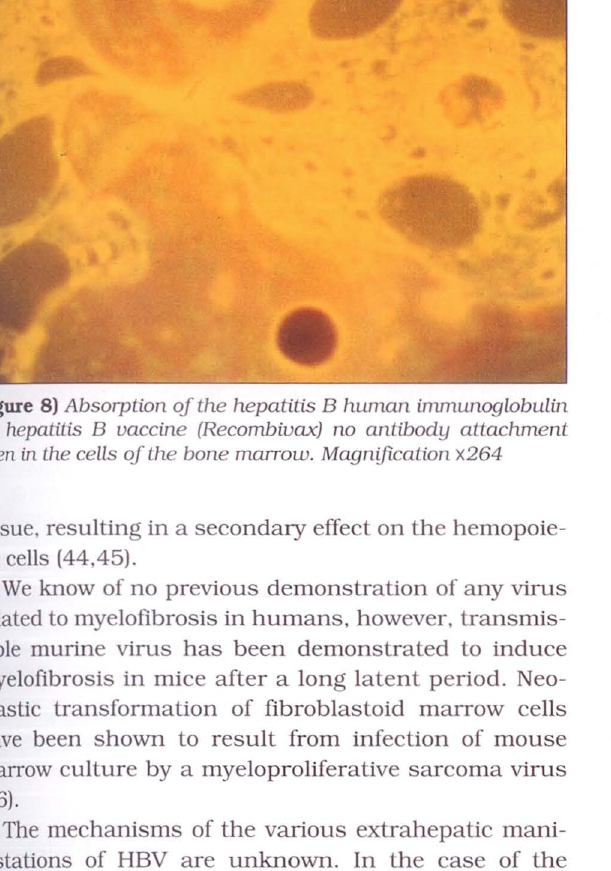
Figure 10) Indirect immunofluorescent staining of the bone marrow antibody attachment seen in the cells of the bone marrow taken during autopsy. Magnification x528